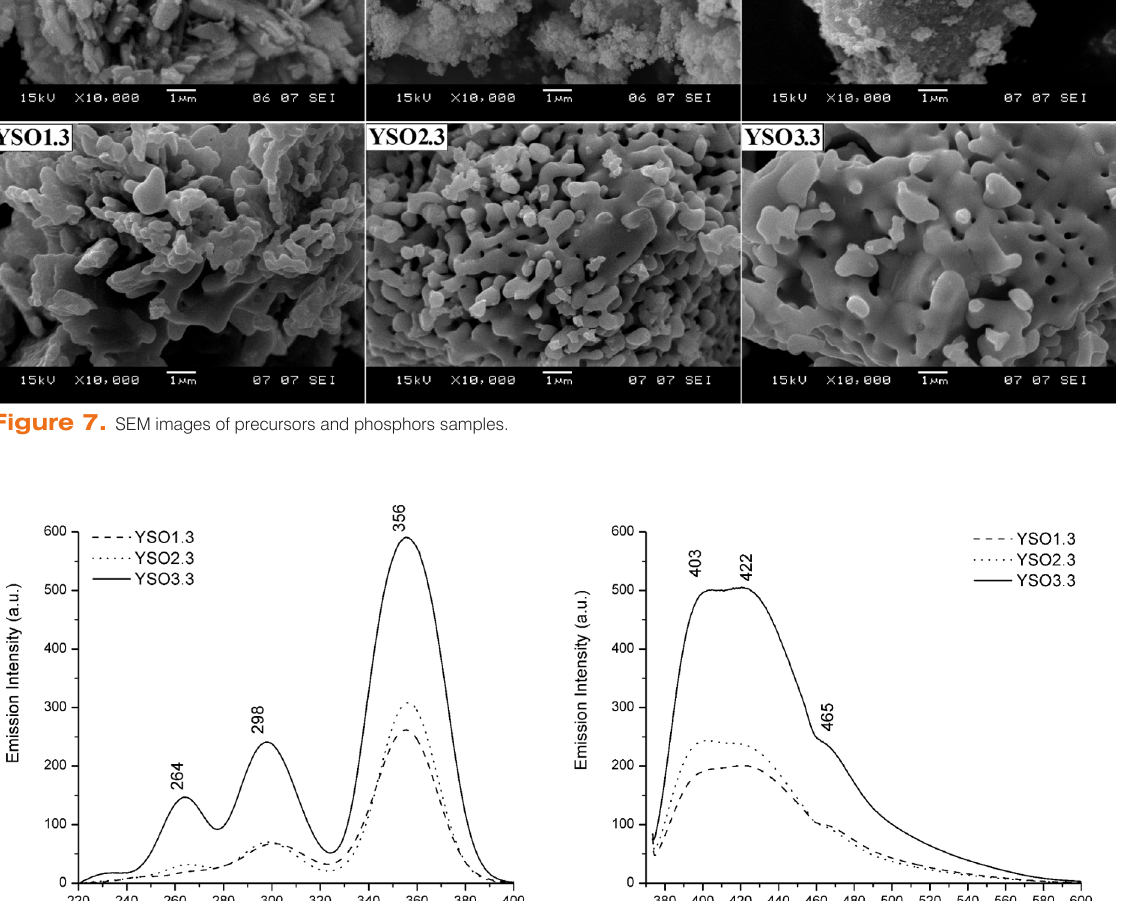
= 400 nm and emission spectra (right) λ em